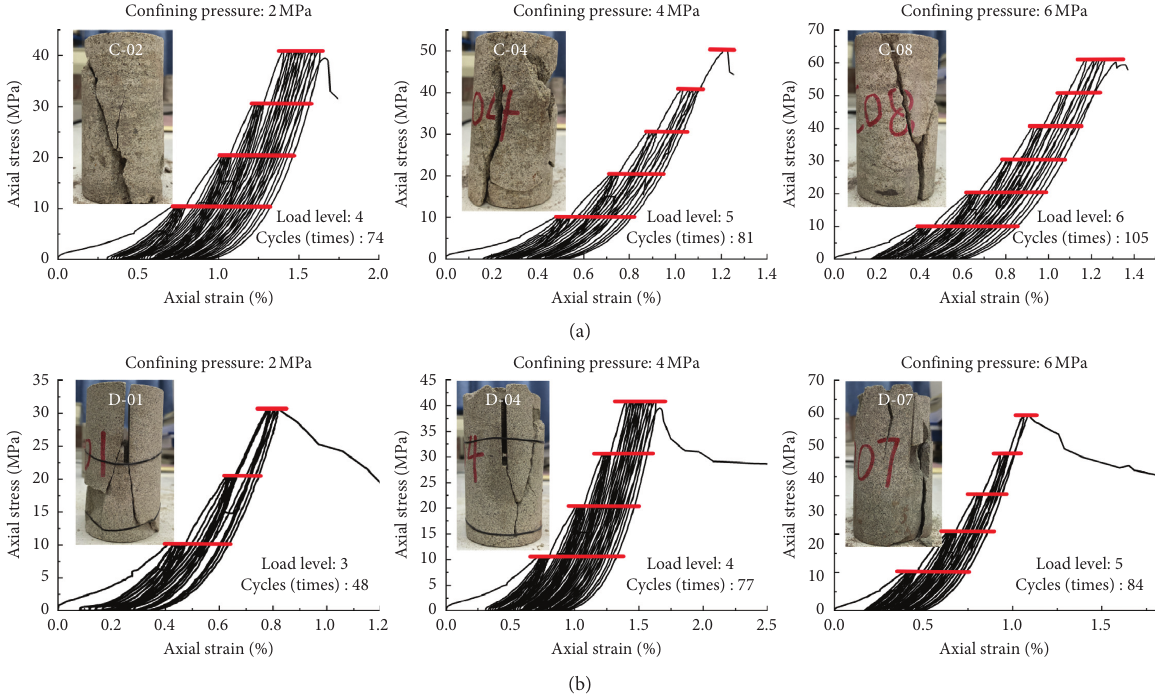
Figure 8: Cyclic triaxial dynamic stress-strain curve and failure characteristics. (a) Sandstone without cracks. (b) Sandstone with